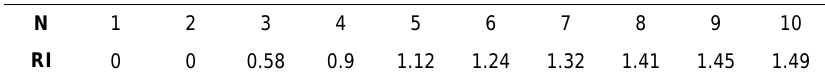
Table 2. Consistency index. Source: Cliff